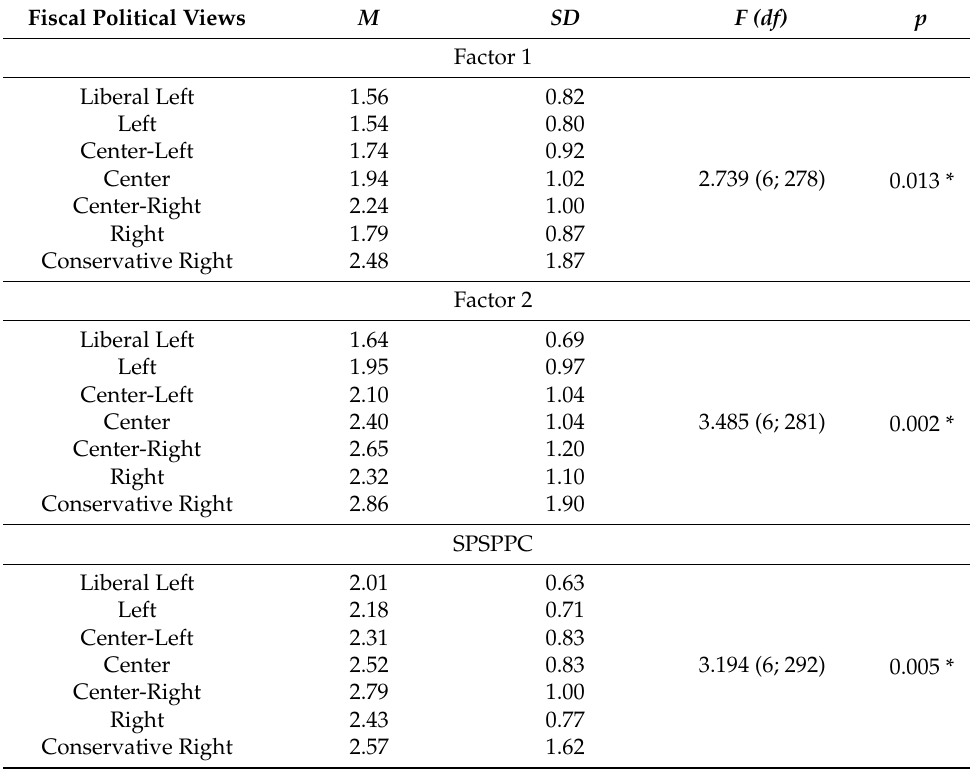
Table 6. Sexual prejudice levels by fiscal political